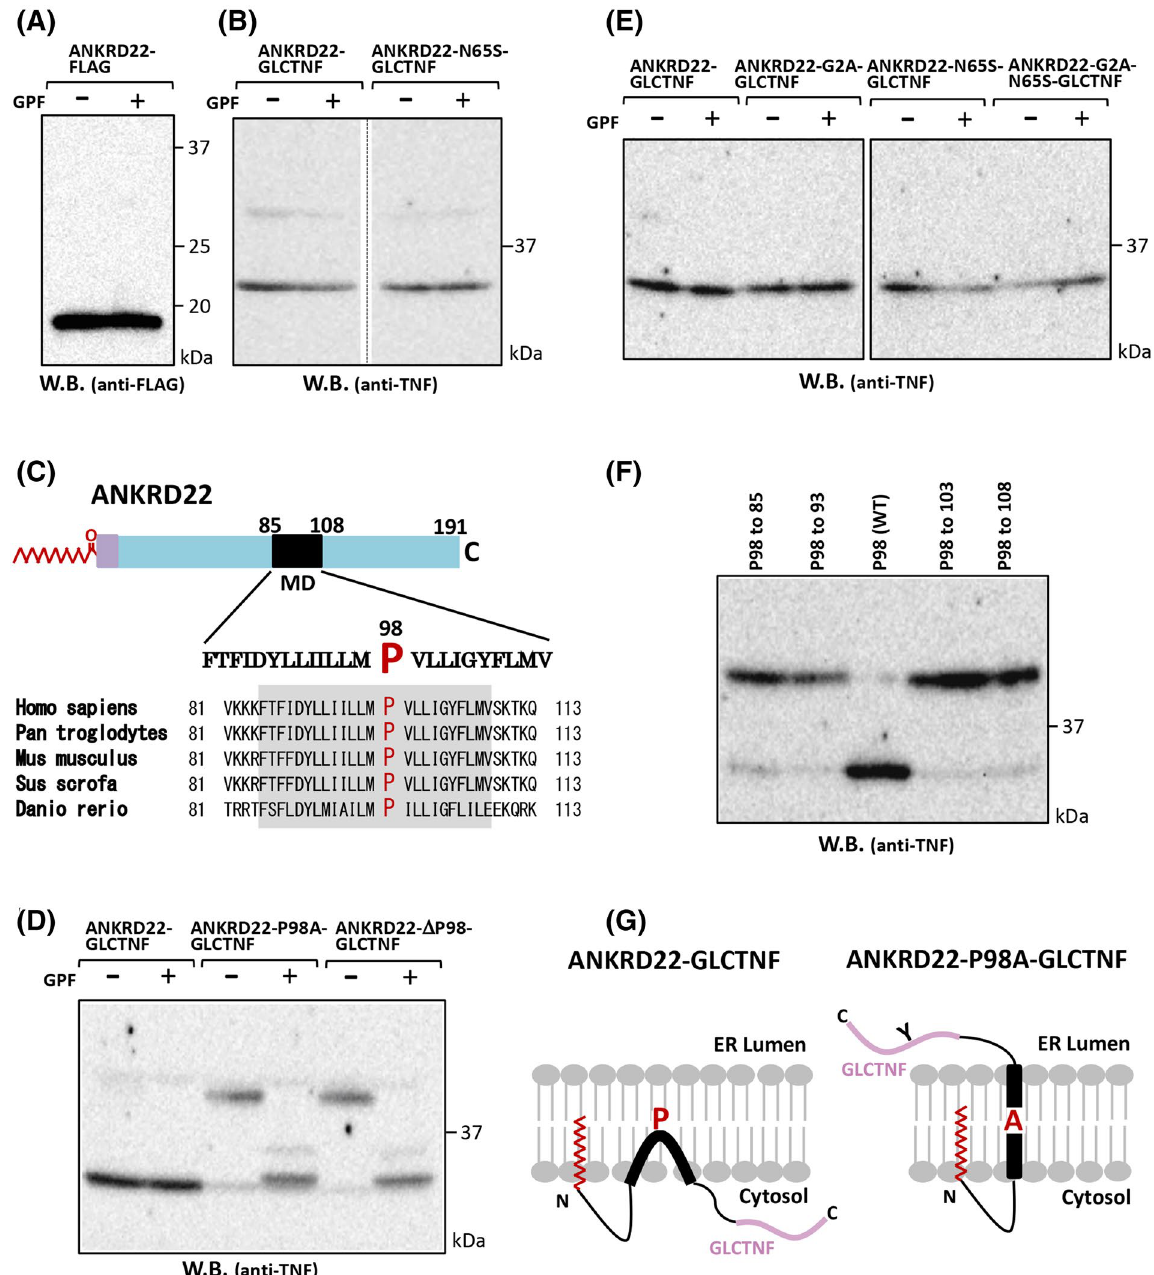
Figure 5. Analysis of the membrane topology of ANKRD22. The membrane topology of ANKRD22 was determined using COS-1 cells transfected with cDNA coding ANKRD22-FLAG, ANKRD22-GLCTNF, and its mutants. For this analysis, the N-glycosylation reaction occurring in the luminal domain of ER was used to assess the translocation of protein across the ER membrane. The names and structure of ANKRD22-GLCTNF and its mutants are summarized in Supplementary Figure S5. ( A , B ) Total cell lysates of COS-1 cells transfected with cDNA coding ANKRD22-FLAG ( A ), ANKRD22-GLCTNF, or ANKRD22-N65S-GLCTNF ( B ) were treated with or without GPF, and then subjected to Western blotting analysis using anti-FLAG or anti-TNF antibody. A part of the blot was cropped. The position of the splice is indicated by vertical dashed line in ( B ). The uncropped raw image data for the blots are shown in Supplementary Figure S10. ( C ) Amino acid sequence of the membrane domain of ANKRD22. Interspecies alignment of the membrane domain of ANKRD22 is shown. The conserved Pro residue is indicated by the red letter. ( D , E ) Total cell lysates of COS-1 cells transfected with cDNA coding ANKRD22-GLCTNF, ANKRD22-P98A-GLCTNF, ANKRD22-ΔP98-GLCTNF ( D ), or ANKRD22-GLCTNF, ANKRD22-G2A-GLCTNF, ANKRD22-N65S-GLCTNF, or ANKRD22-G2A-N65S-GLCTNF ( E ) were treated with or without GPF, and then subjected to Western blotting analysis using anti-TNF antibody. The raw image data for the blots are shown in Supplementary Figures S10 and S11. ( F ) Total cell lysates of COS-1 cells transfected with cDNA coding P98 to 85, P98 to 93, P98(WT), P98 to 103, or P98 to 108 were subjected to Western blotting analysis using anti-TNF antibody. The raw image data for the blot is shown in Supplementary Figure S11. ( G ) Schematic representation of the membrane topology of ANKRD22-GLCTNF and ANKRD22-